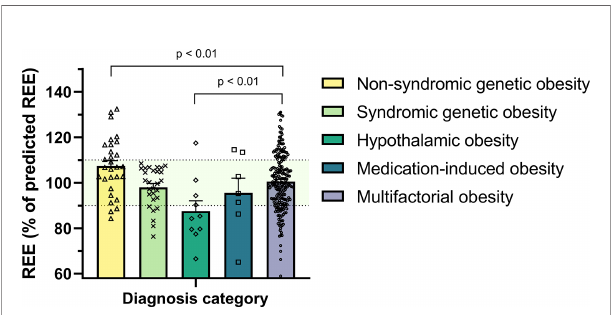
FIGURE 2 | Measured REE expressed as percentage of predicted REE (by Scho fi eld equations) across the study population. Patients with non-syndromic genetic obesity had higher REE% compared to children with multifactorial obesity whereas children with hypothalamic obesity had lower REE% (both p-values <0.01). The dots represent the individual patients. The bars represent the mean + standard error of the mean. The light green shaded area indicates a REE% between 90 and 110%. REE, resting energy expenditure.